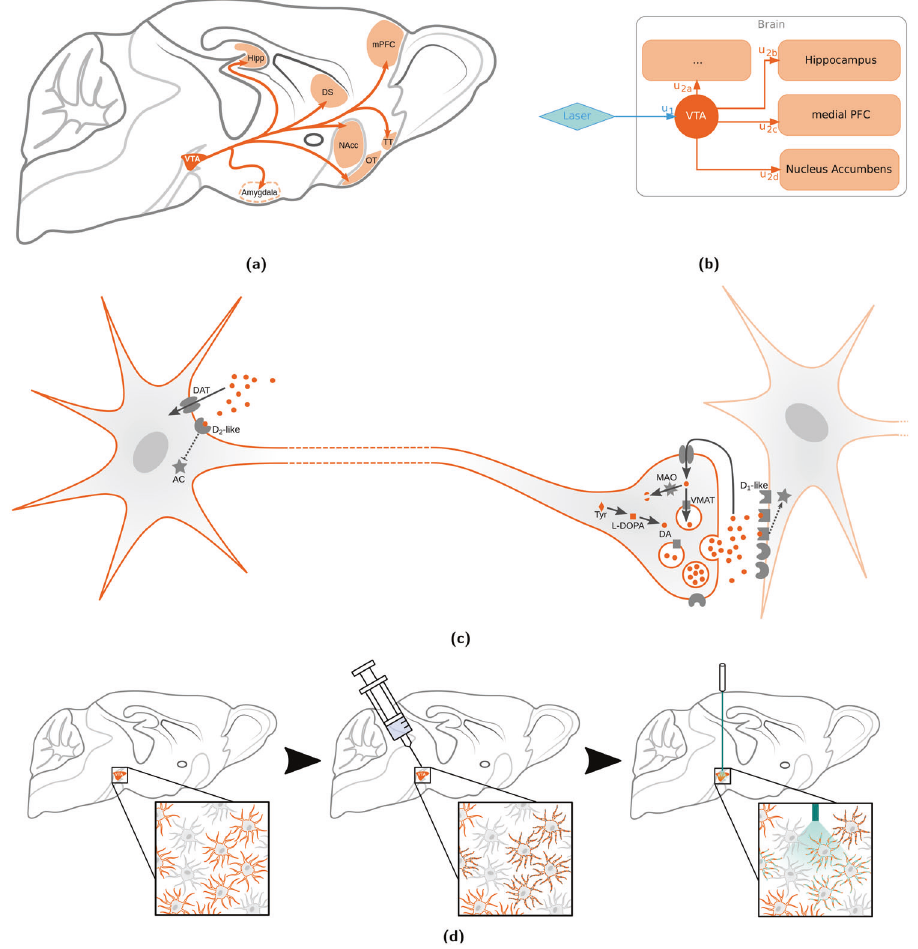
Fig. 1 The cell biological compartmentalization of dopaminergic neurotransmission (and susceptibility to psychopharmacology) can partly be mapped onto neuroanatomical features by a simple network model, using optogenetics. Depicted are schematic overviews of the VTA dopaminergic system at various spatial resolutions. a Schematic map of VTA dopaminergic projections [50, 52 – 54]. Dotted structures are off-slice, and projection arrows do not re fl ect actual fi ber bundle paths. b Simpli fi ed network model of 1-step signal relay following optogenetic stimulation of the VTA. The u 1 weighting corresponds to VTA somatic excitability and u 2a , u 2b , u 2c , and u 2d correspond to transmission at the dopaminergic synapses in the respective projection areas. c Schematic overview of VTA dopaminergic neurons, with the soma located in the VTA and synapses in one or multiple other projection area voxels. Excitability at the soma are contingent on D 2 autoinhibition, while transmission at the synapse is contingent on dopamine metabolism, turnover, and postsynaptic D 1 expression [55]. d Schematic of optogenetic cell selection and activation. Orange denotes dopaminergic cells, gray enlarged elements on the cell periphery indicate channelrhodopsin expression, and cyan segments on the cell periphery denote depolarization events. AC adenylyl cyclase, DA dopamine, DAT dopamine transporter, DS dorsal striatum, Hipp hippocampus, MAO monoamine oxydase, mPFC medial prefrontal cortex, NAcc nucleus accumbens, OT olfactory tuberculum, TT tenia tecta, Tyr tyrosine, VMAT vesicular monoamine